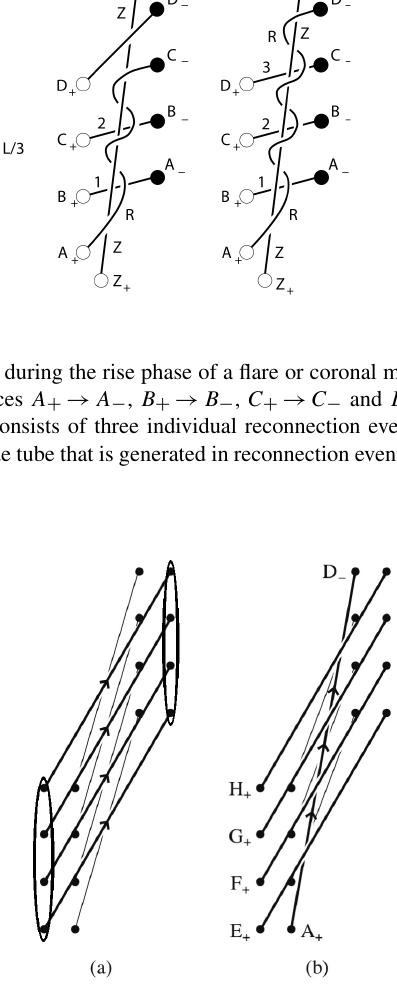
Figure 16. Quasi-2-D reconnection during the main phase of a flare or coronal mass ejection. (a) The initial sheared state. (b) The situ- ation after the zipper phase of the flare when reconnection has pro- ceeded parallel to the polarity inversion line to produce the zipper flux rope ( A + D − ) lying under the next set of field lines joining footpoints E + E − , F + F − , G + G − , H + H − . (c) The first part of the main phase after reconnection has progressed sideways to reconnect the next sheath of field lines and create a spiral sheath that wraps around the zipper flux rope and enhances its flux and magnetic he-